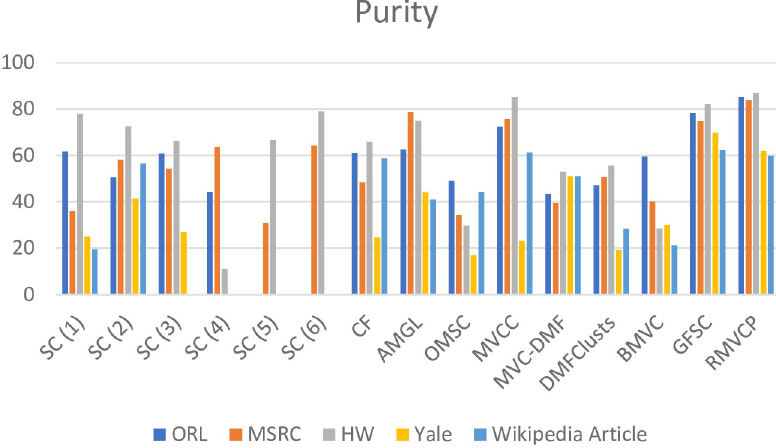
Fig 6. A histogram comparison of the Purity results of all algorithms on the five datasets.